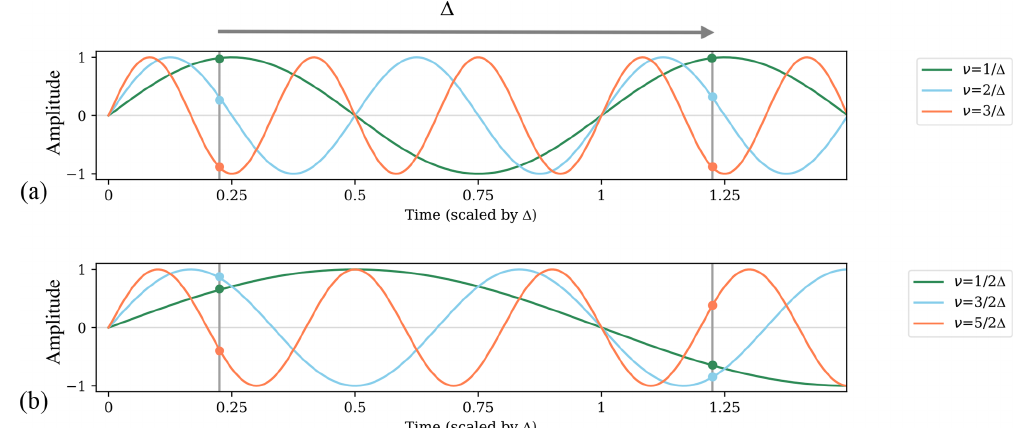
Figure A1. Illustration of the frequency dependence of errors in representing an instantaneous measurement of a process r ( t ) at a time t by another measurement r ( t + (cid:49) ). Each line represents a different frequency component of r ( t ): grey vertical lines represent sampling times, and colored circles represent the values of components at those times. At frequencies ν = n for n = 0 , 1 , 2 ,... , (a) , the Fourier components of (cid:49) (cid:68) (cid:69) x ( t ) will be exactly in phase when sampled at a time lag (cid:49) , so these components do not contribute to the error variance ( r ( t ) − r ( t + (cid:49) )) 2 . + 1 (b) , the Fourier components are exactly out of phase, so these components tend to contribute most to By contrast, at frequencies ν = n (cid:49) 2 (cid:49) the error variance. At intermediate frequencies, contributions lie between the two extremes, leading to a cosine function of error contribution as a function of frequency (Eq.